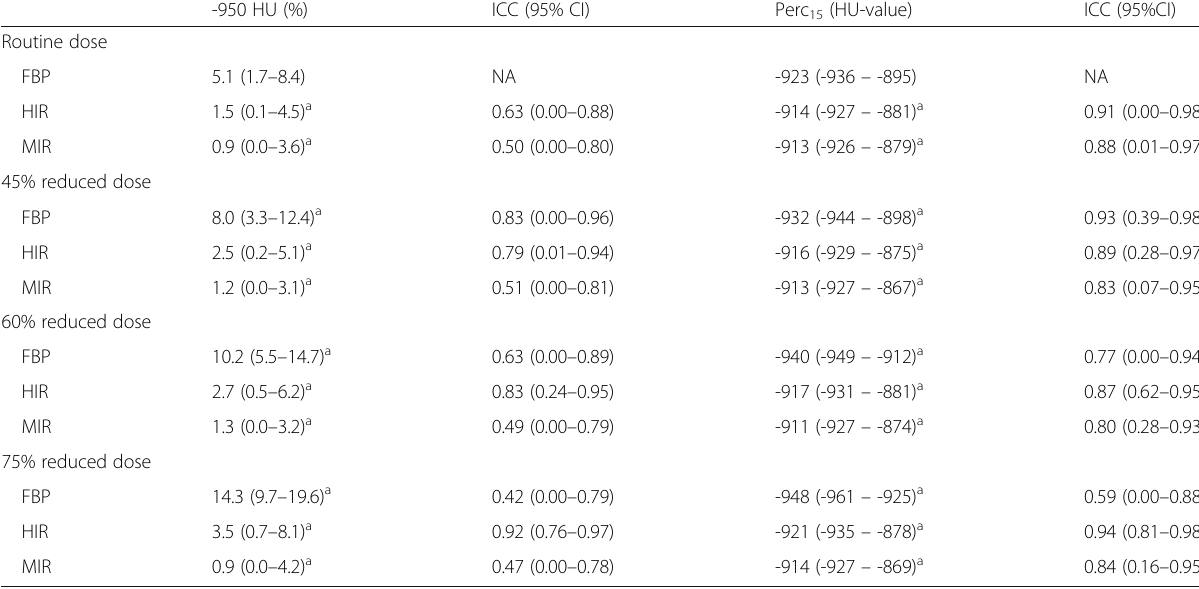
Table 1 Percentage of emphysema using the -950 HU threshold and the perc 15 method at different dose levels reconstructed with FBP, HIR and